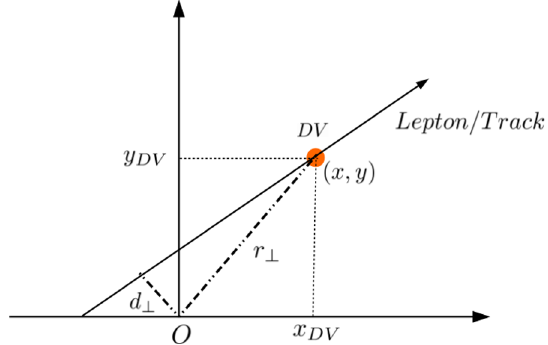
Figure 2 . Schematic view in the transverse plane of a long-lived particle